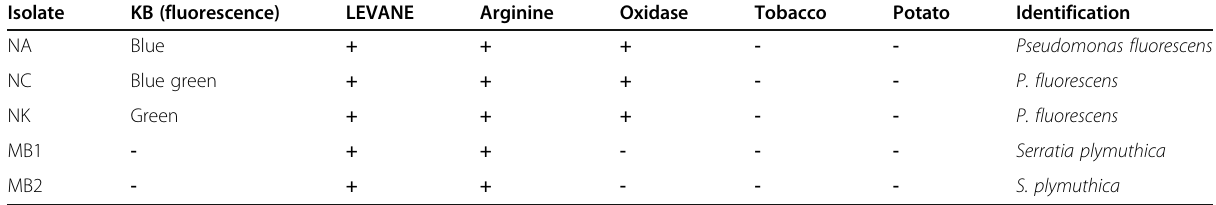
Table 1 Biochemical characterization of